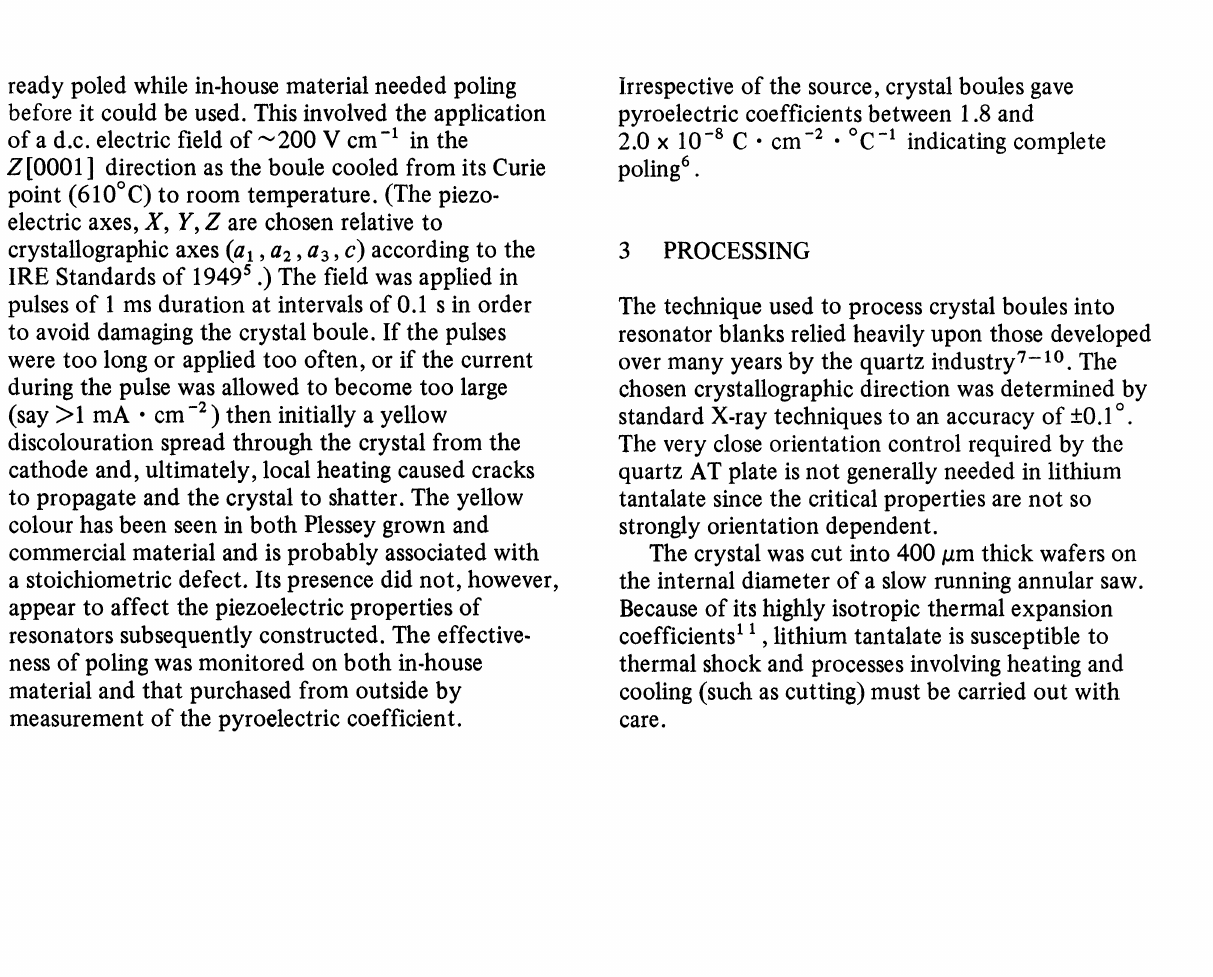
FIGURE 1 Temperature variation of frequency in quartz, LiTaO and